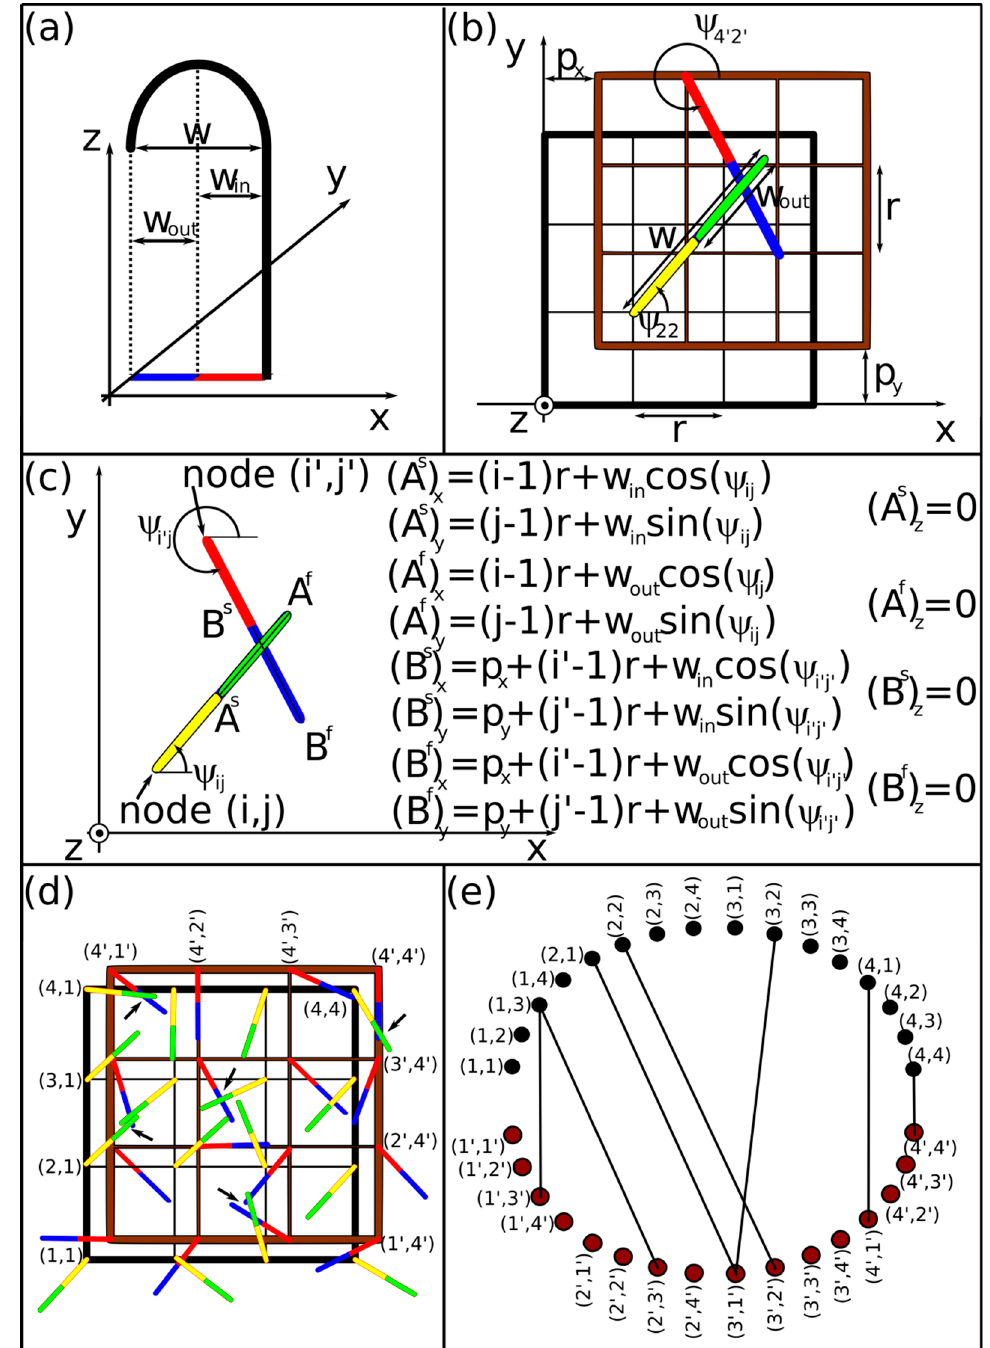
Figure 6. Parameters of a single NiTi hook ( a ) and either hook array ( b ). The projection of an interlocked hook pair and the corresponding coordinates (of points A s , A f , B s , and B f ), expressed using the hook and hook array parameters ( c ). An example of two hook arrays with their nodes ( d ) and the corresponding undirected graph ( e ).